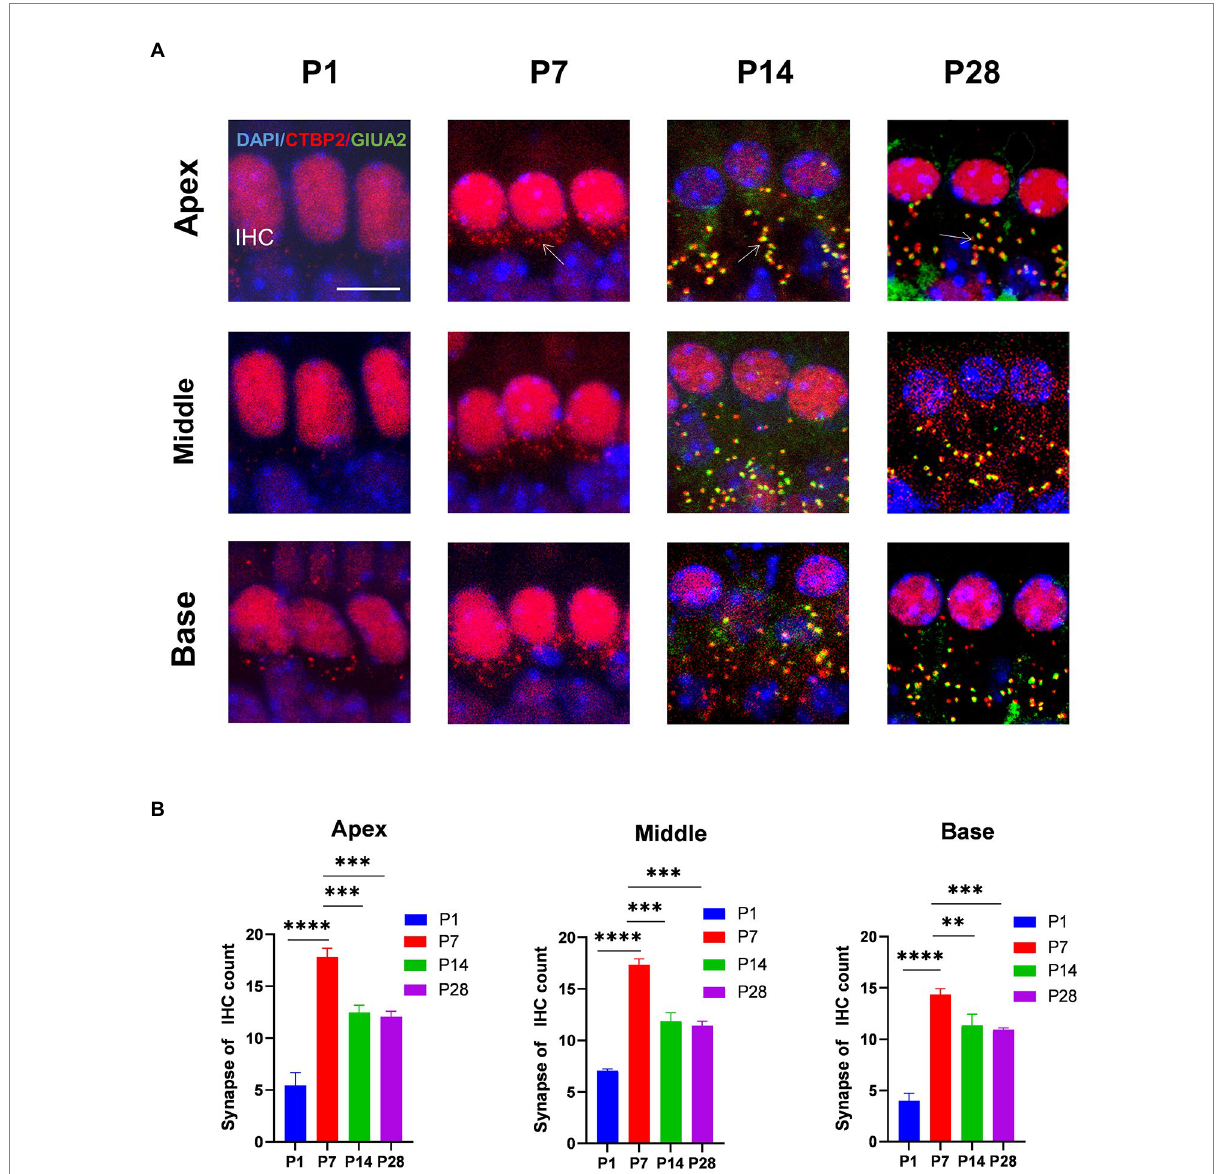
FIGURE 1 The number of synapses during postnatal mouse cochlear development is detected from P1 to P28. (A) : ctbp2 dots (red) and glua2 dots (green) on immunofluorescence staining show the dynamic changes in presynaptic and postsynaptic proteins on P1, P7, P14, and p28. Scale bar = 5 μ m, n = 3. The image at the bottom is an enlarged image of macrophages. (B) The number of synapses per IHCs is increased from birth to P7 until P14, after which the number of synapses are stabilized. ** p < 0.01, *** p < 0.001, **** p <